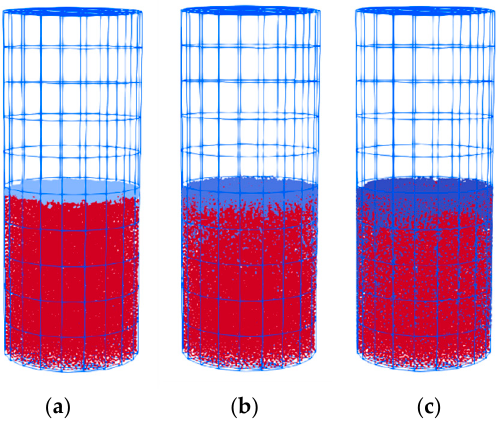
Figure 6. Three types of filter cake on the sand column surface: ( a ) Type I; ( b ) Type II; ( c ) Type III.